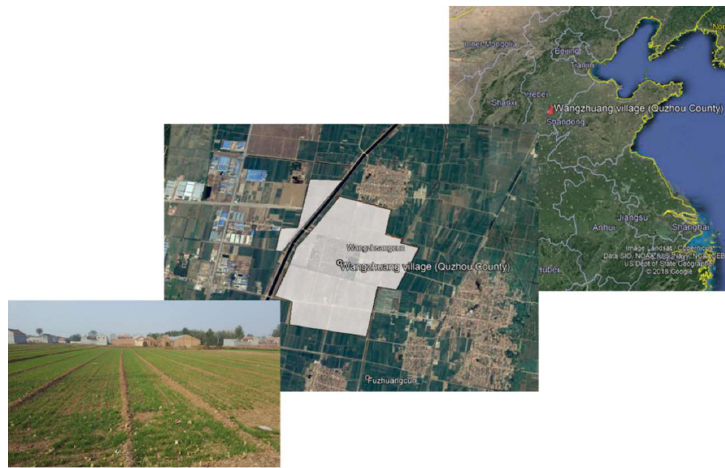
Figure 1. Location of the Wangzhaung village in China (red mark), the area occupied by the village (white polygon), and an image of the typical field layout in Wangzhuang village, China. The fields were separated only by a thin bare patch of soil. The similar growth stages of the wheat plants suggest that planting occurred at the same time in the different fields.